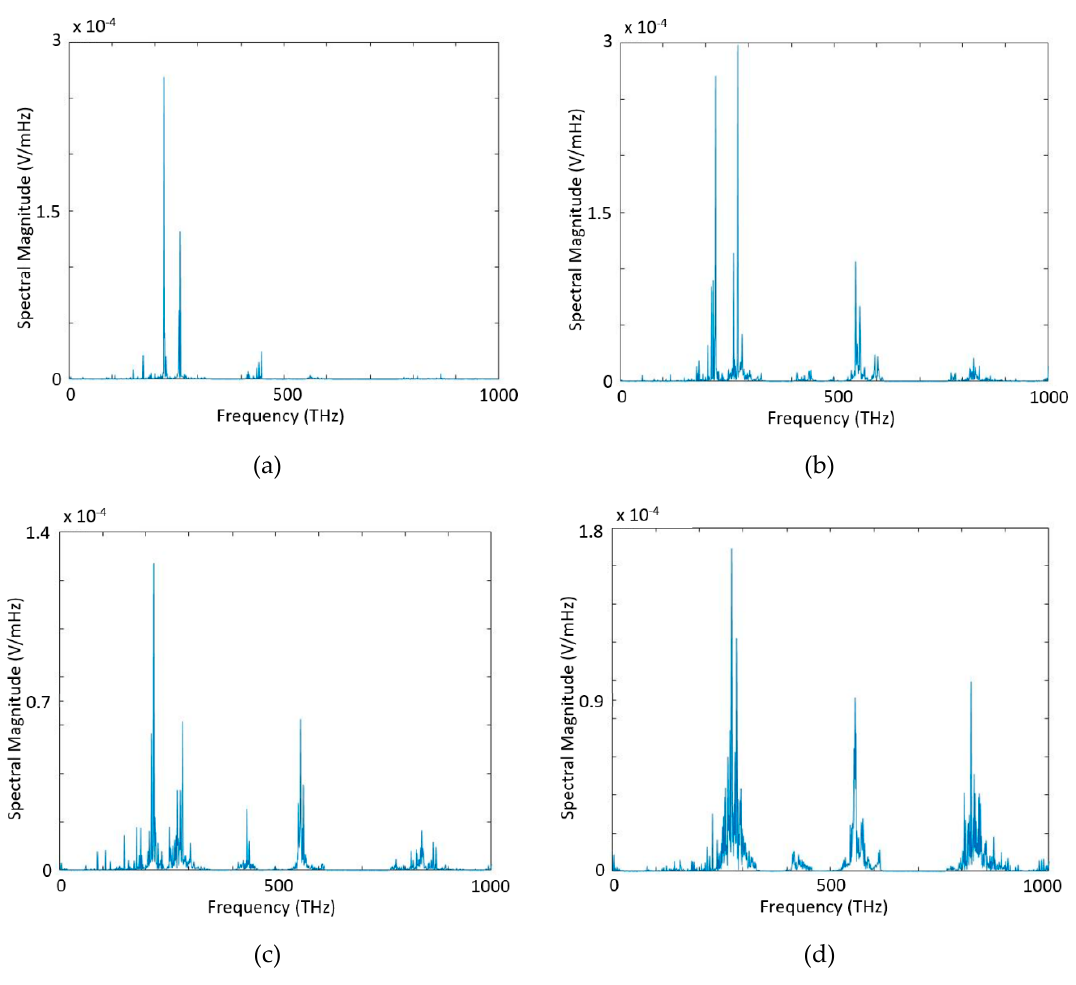
Figure 5. Spectrum of the total wave inside the cavity measured at x = 5.73 μ m, t = 10 ps, at ( a ) 6th, ( b ) 8th, ( c ) 10th, and ( d ) 13th iteration of the optimization process for harmonic generation at 820 THz.